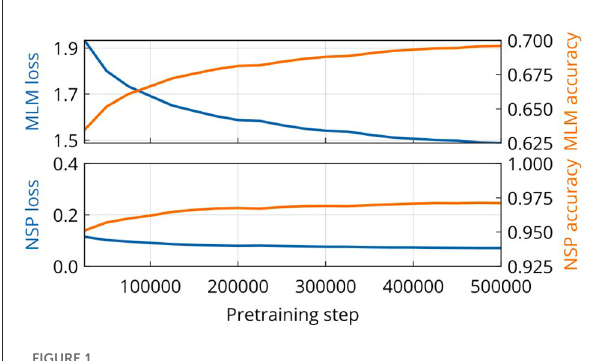
FIGURE1 Evaluation metrics for the domain-specific pretraining of CT-BERT . Shown are the loss and accuracy of masked language modeling (MLM) and next sentence prediction (NSP)